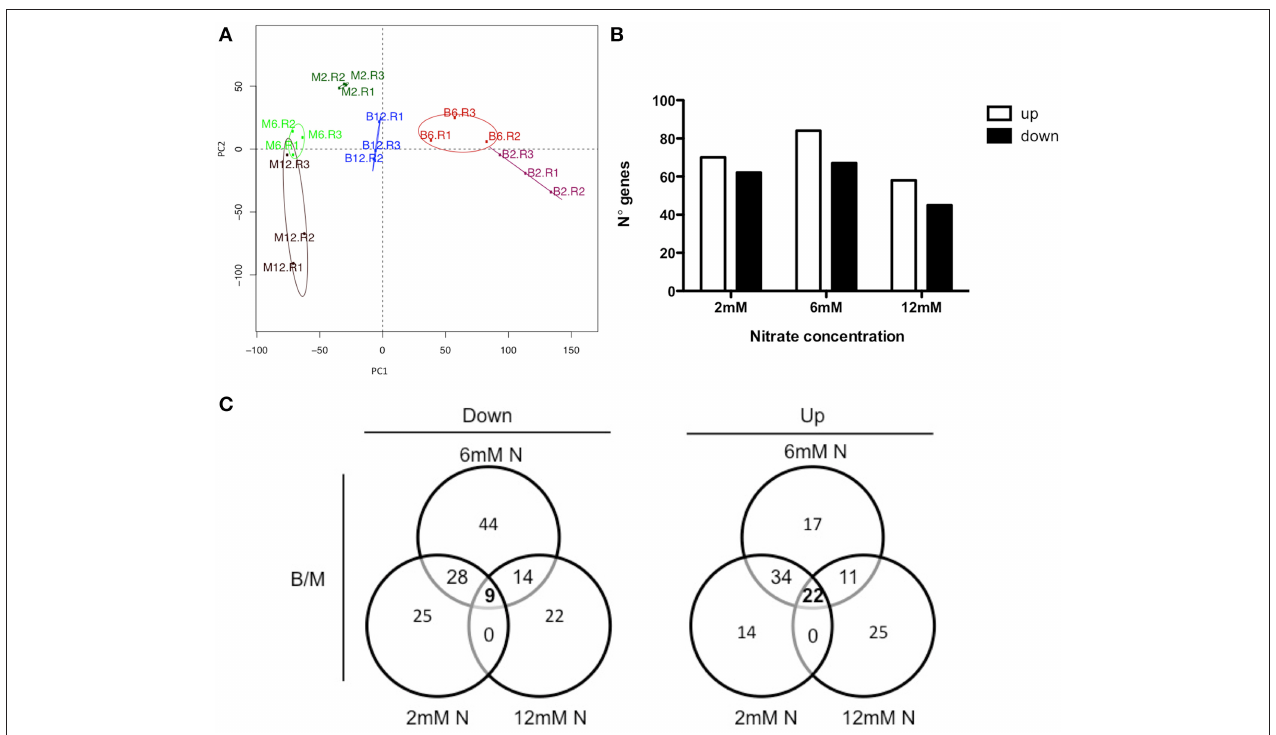
FIGURE 3 | The plant N-availability affects global gene expression in response to B. cinerea infection in tomato. (A) Principal component analysis (PCA) of RMA-normalized global gene expression data demonstrate a connection between plant N-status and B. cinerea susceptibility. Colored dots denote each biological replicate. “M” and “B” indicate mock-treated and B. cinerea -infected plants, respectively, while the number next to each dot indicate the N concentration. (B) Number of genes that are either up- or down-regulated by the B. cinerea infection in each N condition analyzed in comparison to mock-inoculated plants (ANOVA; Rank-product, adjusted p < 0.05 ). (C) Venn diagrams of the data presented in (B) showing the overlap of genes that are either up- or down-regulated in tomato inoculated with B. cinerea in each N condition comparing with corresponding mock-treated samples